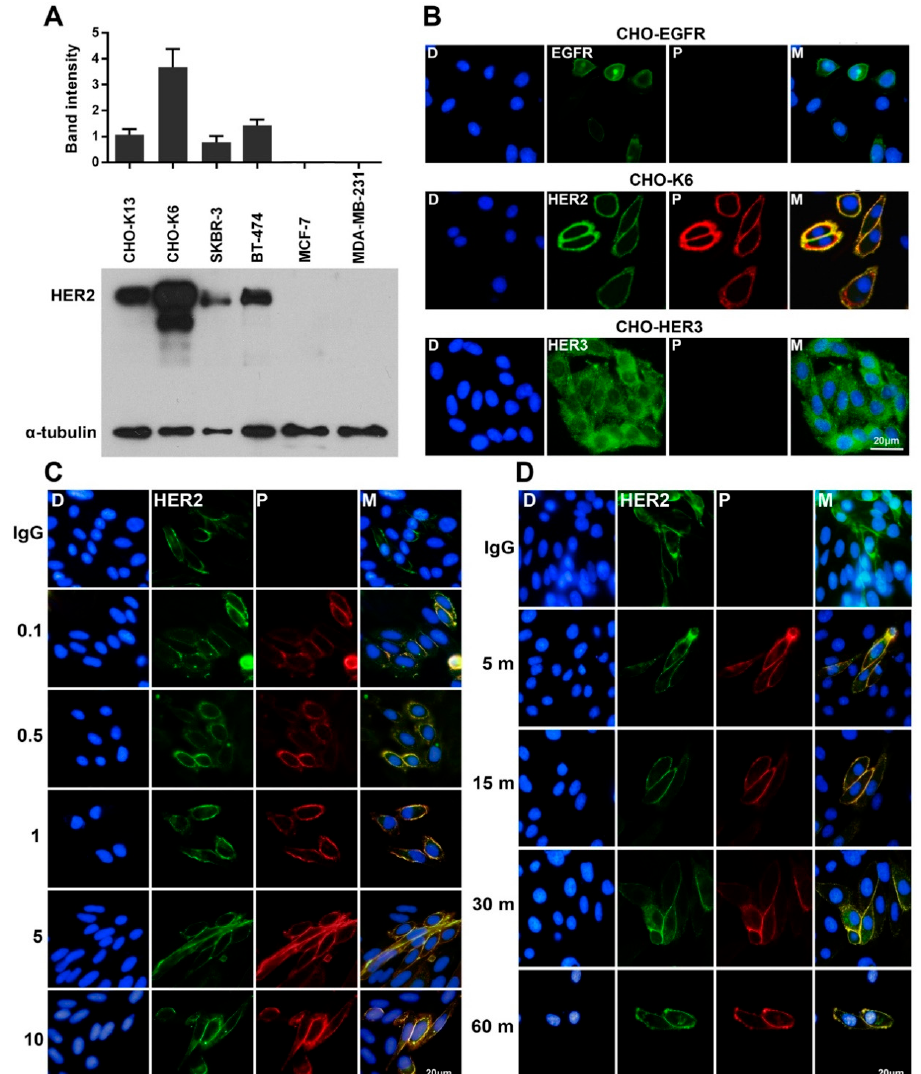
Figure 1. Specific binding of pertuzumab to HER2. ( A ) The expression levels of HER2 in CHO cell lines stably overexpressing HER2 (CHO-K13 and CHO-K6), two HER2-positive (SKBR-3 and BT-474) and two HER2-negative (MCF-7 and MDA-MB-231) breast cancer cell lines. ( B ) Double-immunofluorescence staining of EGFR, HER2, and HER3 (green) and pertuzumab (P; red) in CHO-EGFR, CHO-K6, and CHO-HER3 cell lines. Pertuzumab binds specifically to HER2 but not to EGFR and HER3. ( C , D ) Double-immunofluorescence staining of HER2 (green) and pertuzumab (red) in the cells ( C ) treated with 0.1, 0.5, 1, 5, and 10 µg/mL pertuzumab for 60 min (dose-course treatment) and ( D ) treated with 10 µg/mL pertuzumab for 5, 15, 30, and 60 min (time-course treatment). Treatment with 10 µg/mL of human IgG for 60 min was used as a mock control.